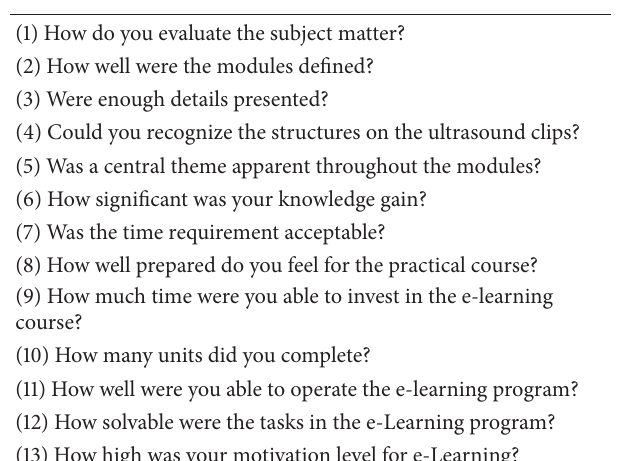
Table 3: Questions of qualitative evaluation survey of the e-learning program using linear analogue self-assessment by medical doctors.